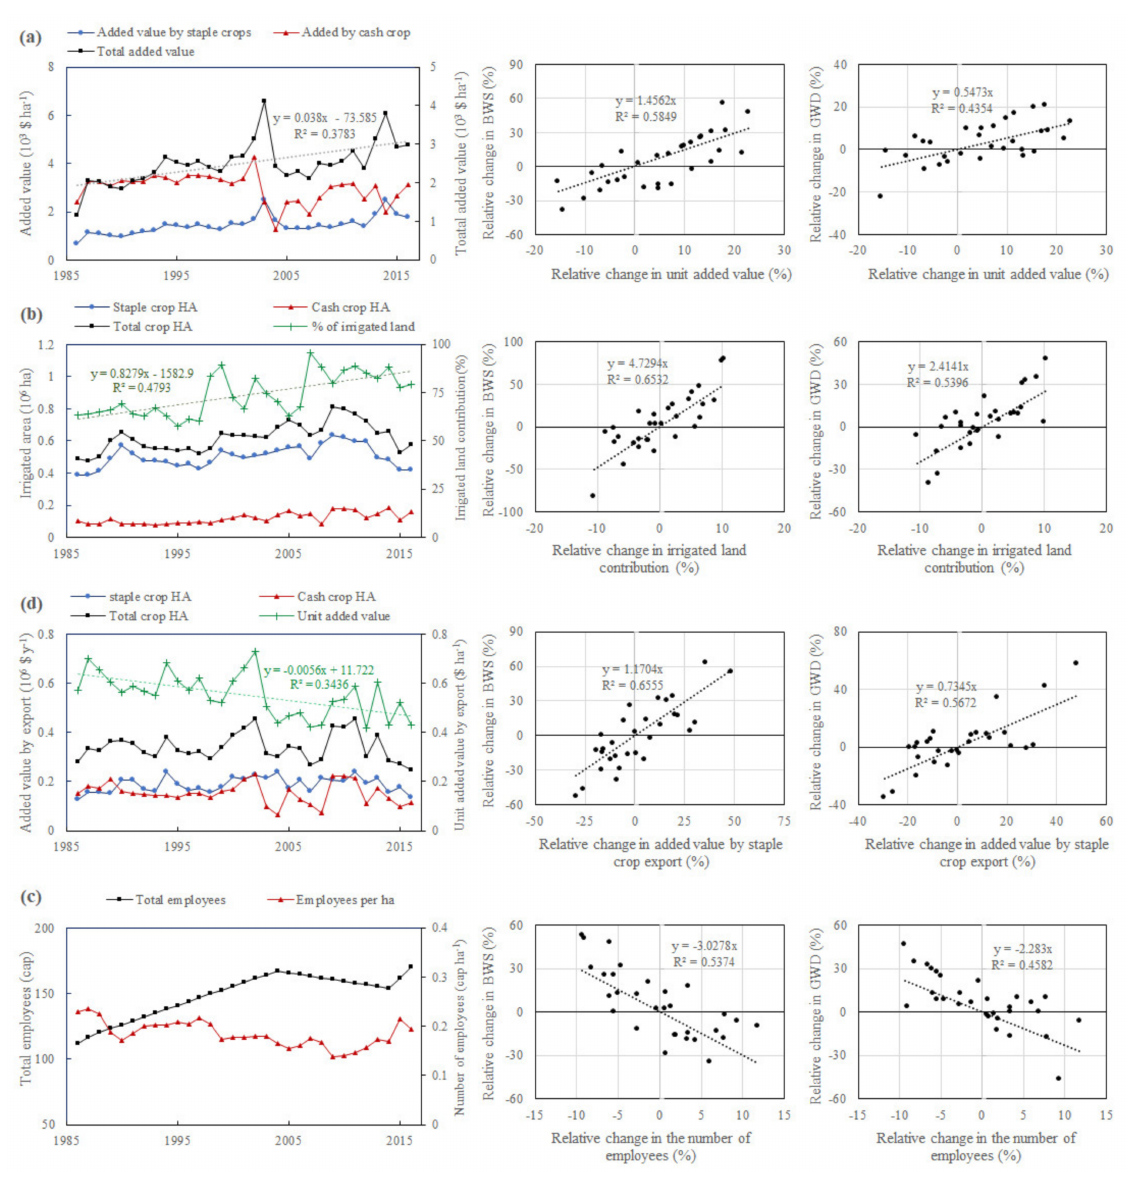
Figure 14. ( a – d ) Benefits obtained at the cost of raising blue water scarcity in the Khuzestan province over the period 1986–2016. i.e., BWS denotes blue water scarcity, GWD is groundwater depletion, and HA is